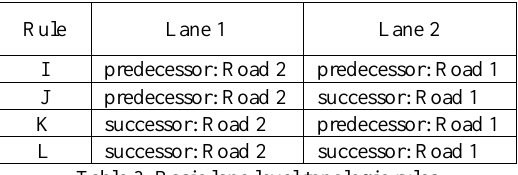
Table 3. Basic lane level topologic rules